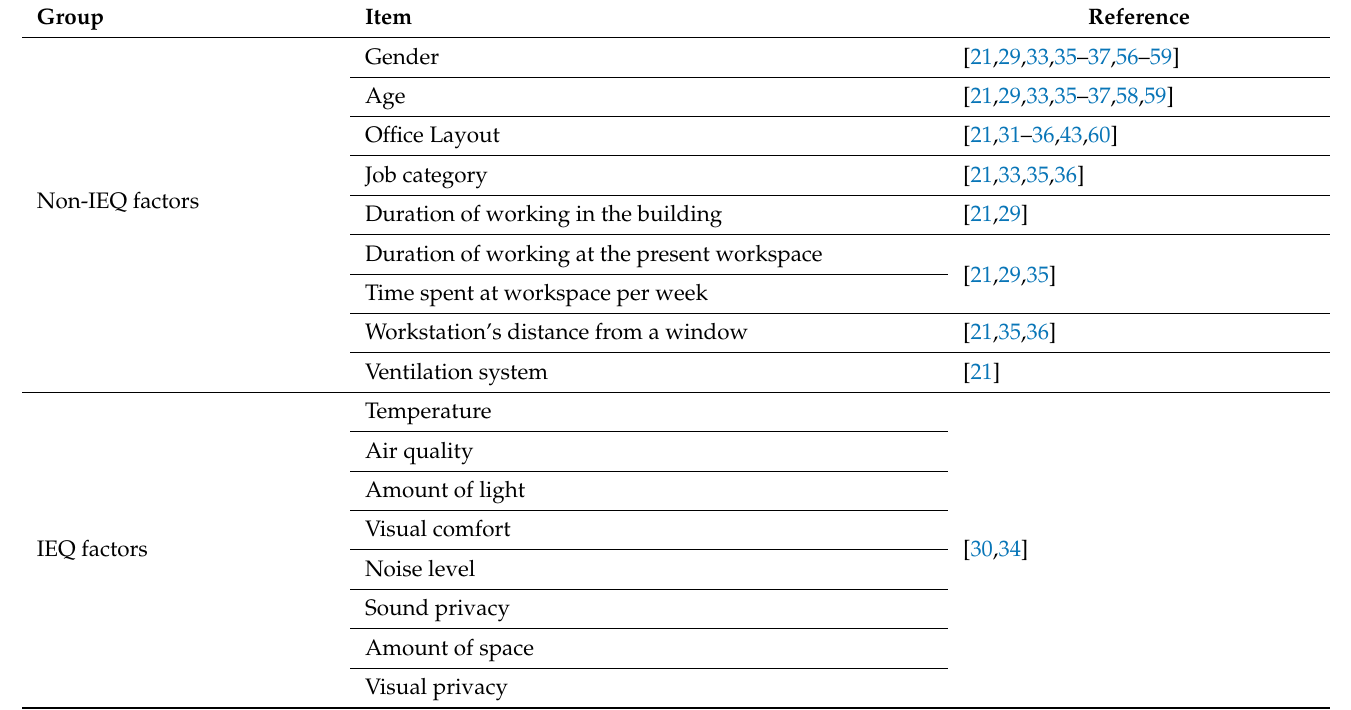
Table 1. Items of the